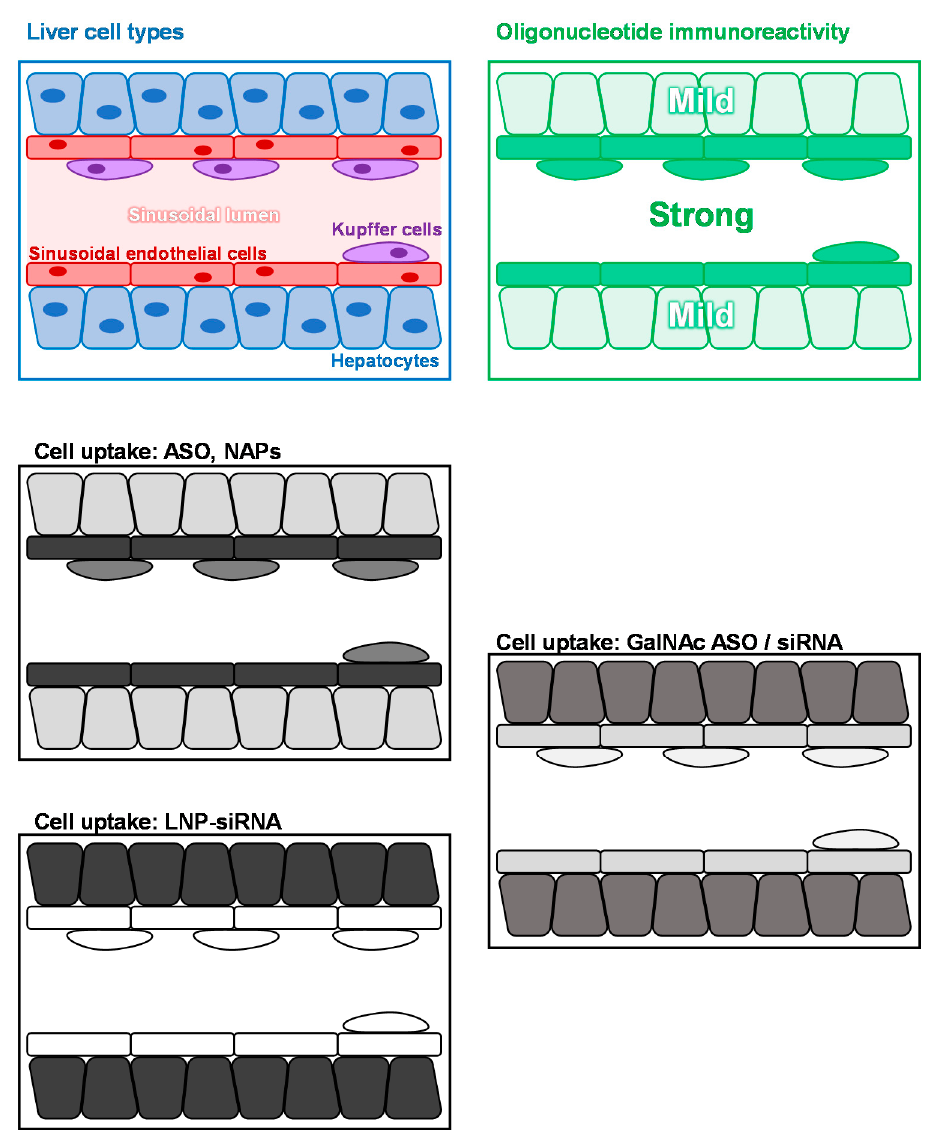
Figure 4. Impact of oligonucleotide uptake in the liver versus immunostimulatory impact. A map of the most prevalent liver cell types is at upper left. Relative immunoreactivity to oligonucleotides via TLR3/7/8 and 9 is indicated at upper right. Cell uptake with oligonucleotides are indicated as unconjugated ASOs (middle left), LNP formulation siRNA (lower left) and GalNAc conjugated-ASO or siRNA (lower right). Stronger cellular accumulation is indicated by darker shading.